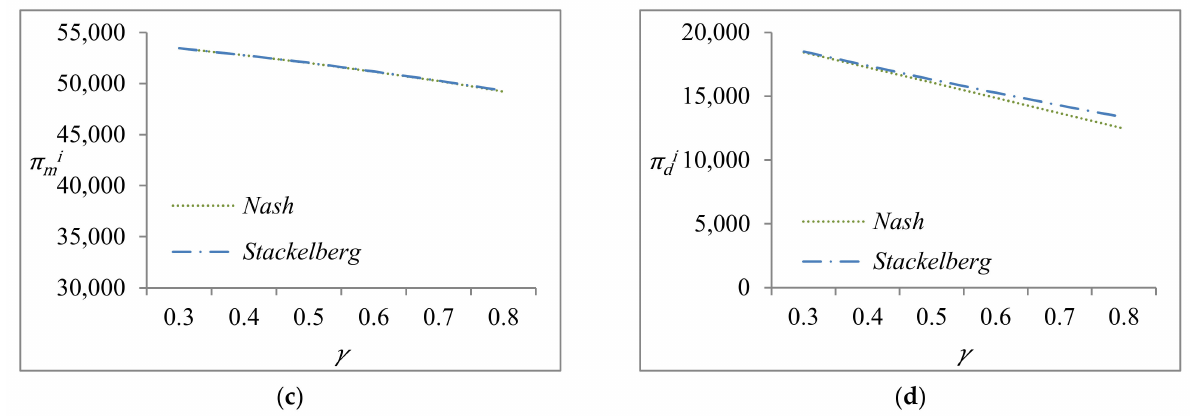
Figure 7. Effect of physical store’s salvage price on: ( a ) manufacturer’s decision; ( b ) retailer’s decision; ( c ) manufacturer’s profit; ( d ) retailer’s profit, when ε value is high. The following market condition is used: r = 0.2, r r = 0.2, ε = 0.005, h = 30, α m = α o = α r = 100, γ = variable, γ r = 0.2, p = 600, v r = 400, v o = 20, c d = 420, c m = 100, ∅ =